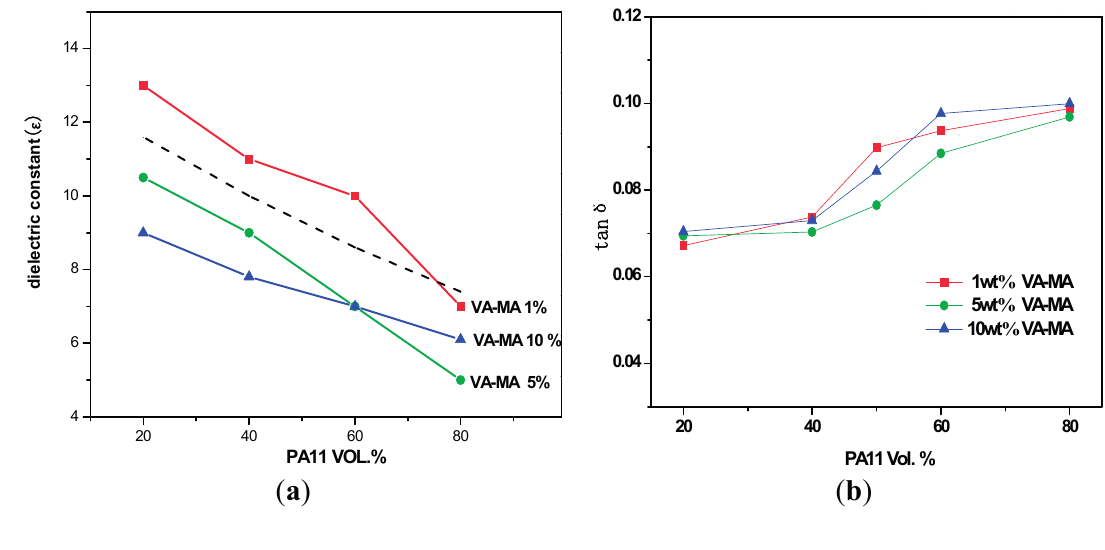
Figure 2. Variations of ( a ) the dielectric constant and ( b ) the dielectric loss of PA11/PVDF blend versus volume fraction of PA11 at room temperature on 10 3